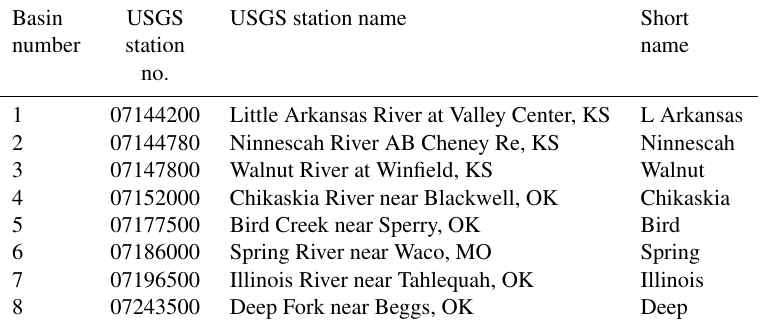
Table 1. List of USGS streamflow sites used for